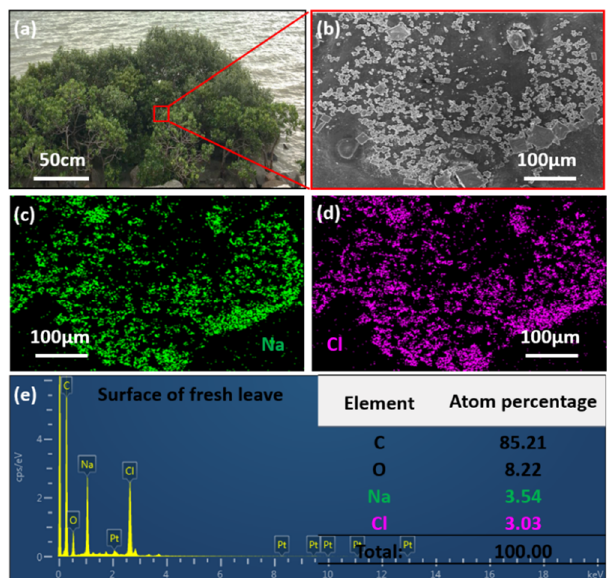
Figure 1. The mangrove and the deposited salt on the surface of fresh mangrove leaves. ( a ) The natural mangrove plants along the Shenzhen Bay. ( b ) SEM of the deposited salt on mangrove leaves, ( c ), ( d ) and ( e ) EDS of the deposited salt particles.